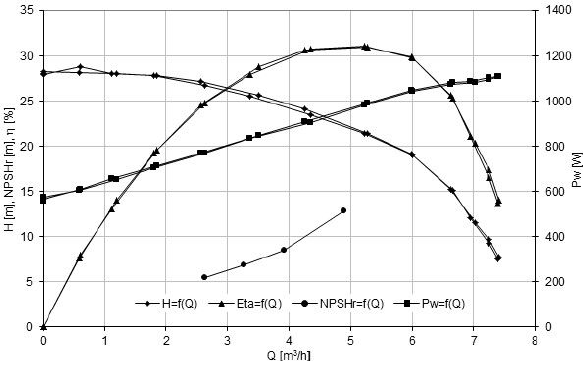
Figure 7: Characteristics of the Impeller